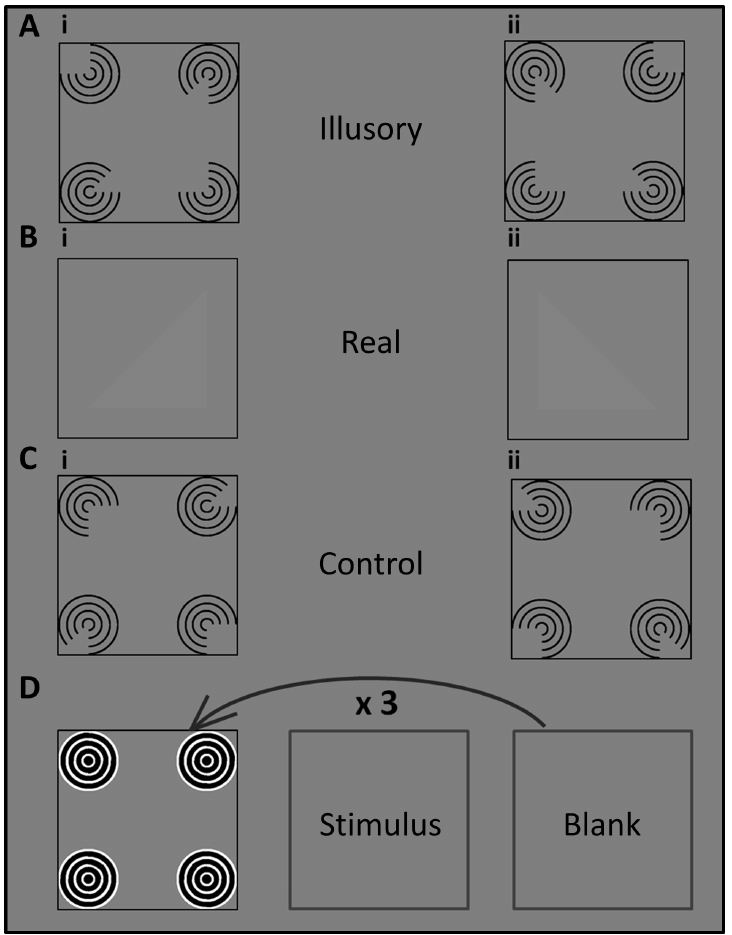
Fig 1. Illustration of the stimuli. A) (i) Kanizsa triangle pointing right (ii) Kanizsa triangle pointing left. B) (i) Real triangle pointing right (ii) Real triangle pointing left. C) Control stimuli were created by a systematic 180° rotation of the individual Pacmen. D) Illustration of the masking procedure in the invisible conditions: A mask- stimulus-blank screen frame sequence was repeated three times. In the visible conditions a blank screen replaced the